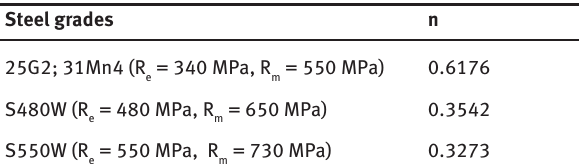
Table 2: Material plasticising coefficient Steel grades